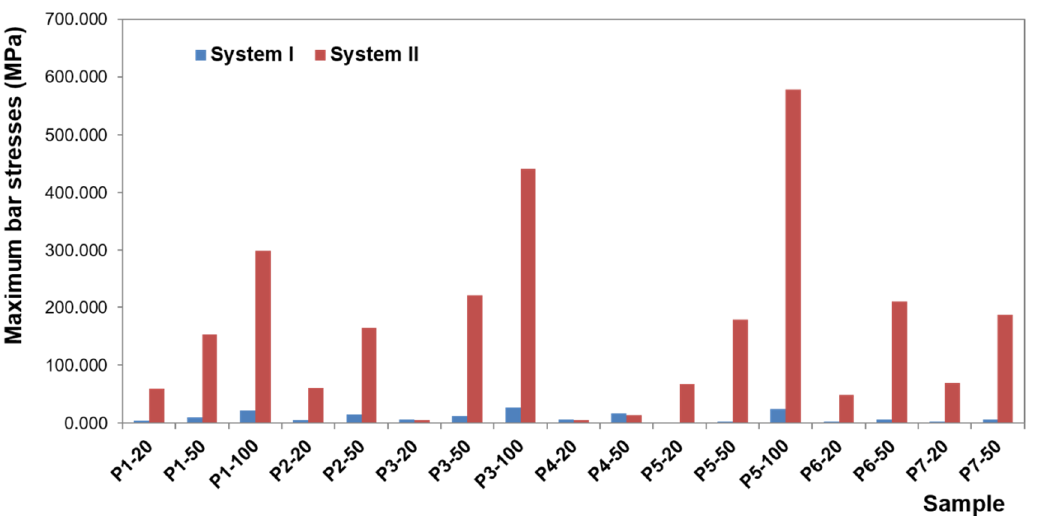
Figure 10. Maximum bar stresses in the first and second system.